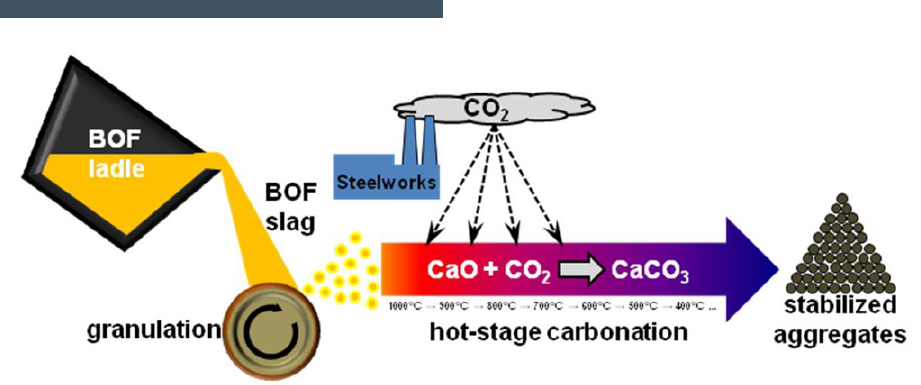
Figure 3. Stabilization of basic oxygen furnace slag by hot-stage carbonation treatment. Reprinted from Chemical Engineering Journal, Vol. 203, Santos et al. [40], 239-250, Copyright 2012, with permission from Elsevier.